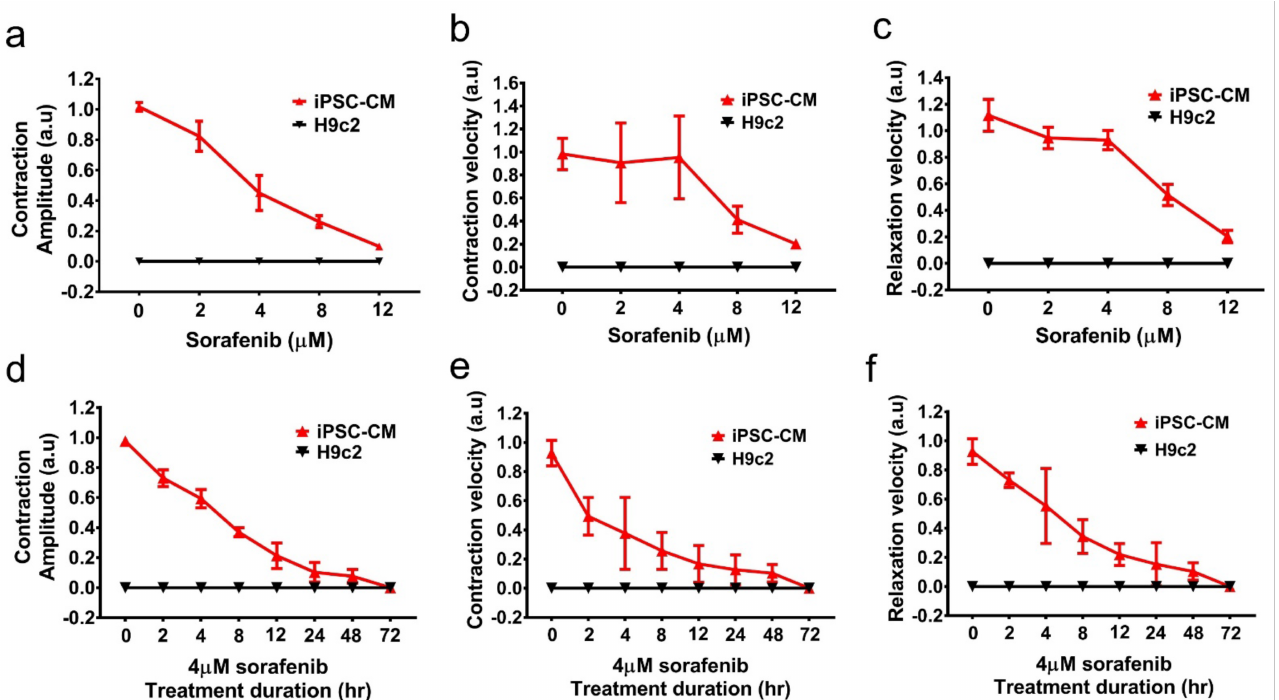
Figure 2. Contractile dysfunction in sorafenib-treated iPSC − CMs. ( a – c ) Dose-dependent muscle motion of iPSC − CMs and H9c2 cells under 0, 2, 4, 8, and 12 µ M sorafenib treatment for 24 h. ( a ) Contraction amplitude, ( b ) contraction velocity, and (c) relaxation velocity. ( d – f ) Time-dependent muscle motion of iPSC − CMs and H9c2 cells treated with 4 µ M sorafenib for 72 h. ( d ) Contraction amplitude, ( e ) contraction velocity, and ( f ) relaxation velocity. Each data point represents the mean ± SEM ( n =